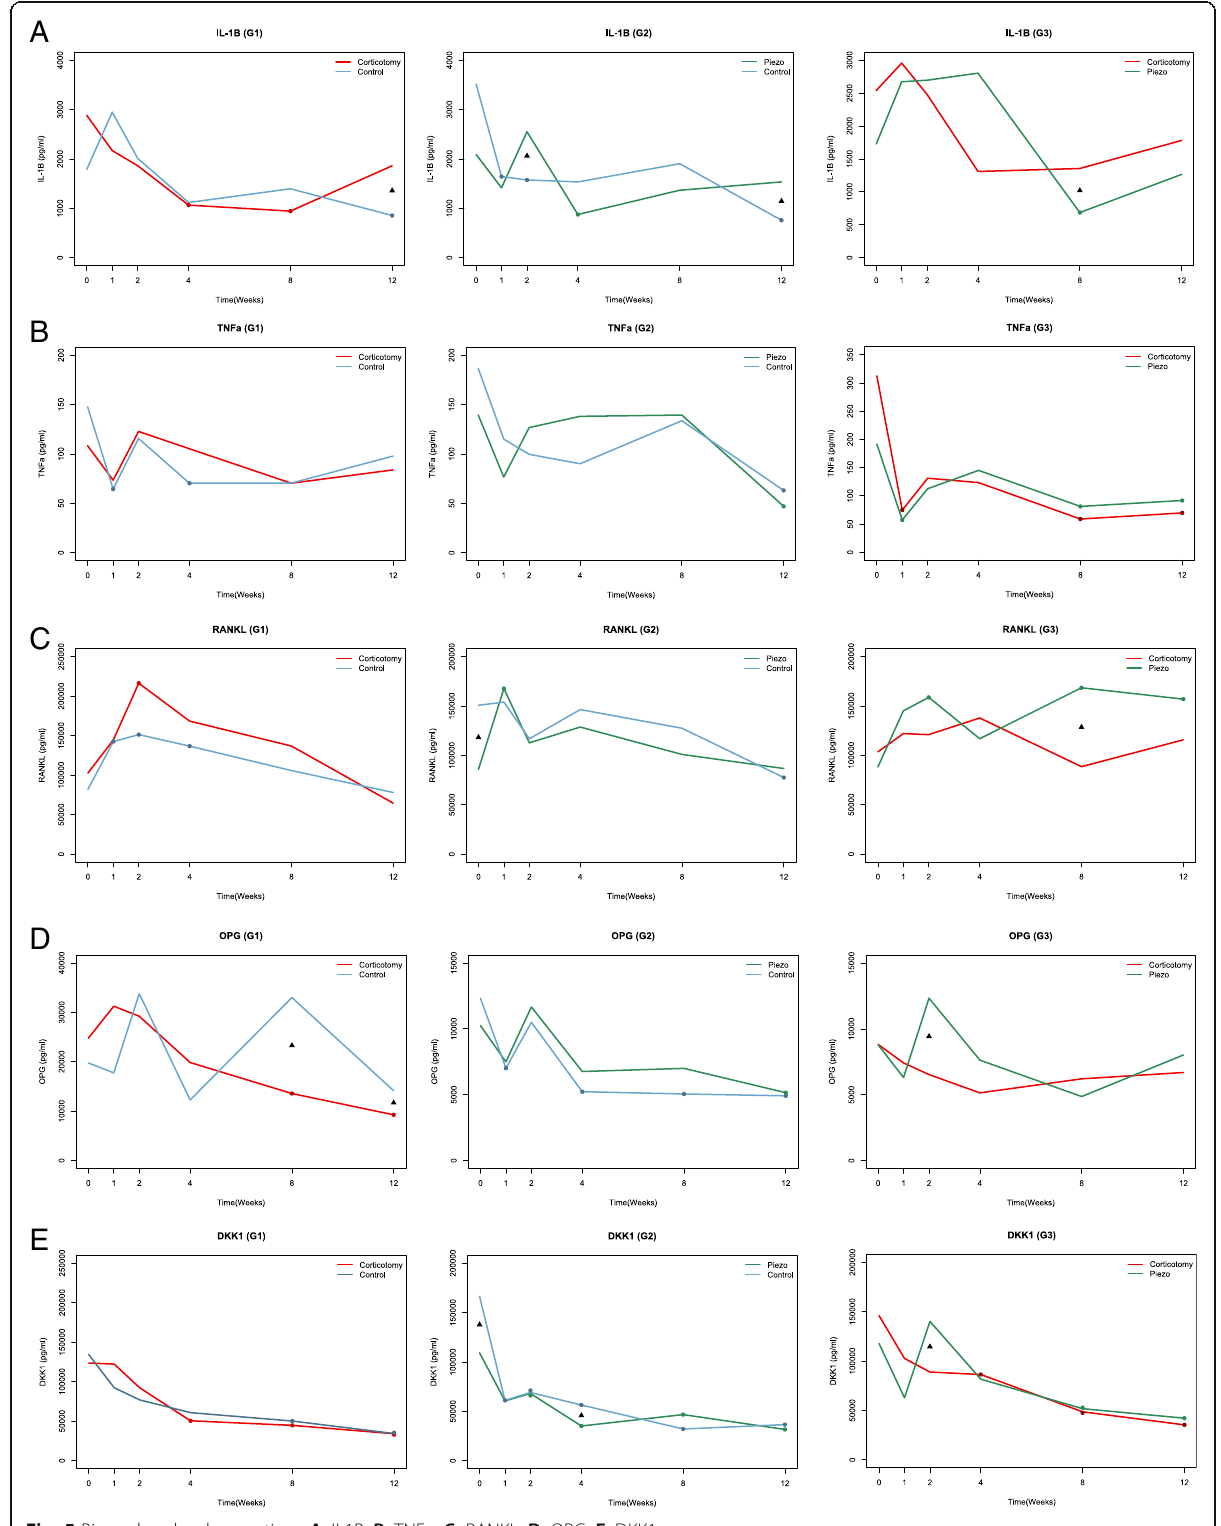
Fig. 5 Biomarkers levels over time. A , IL1B; B , TNFa; C, RANKL; D , OPG; E ,